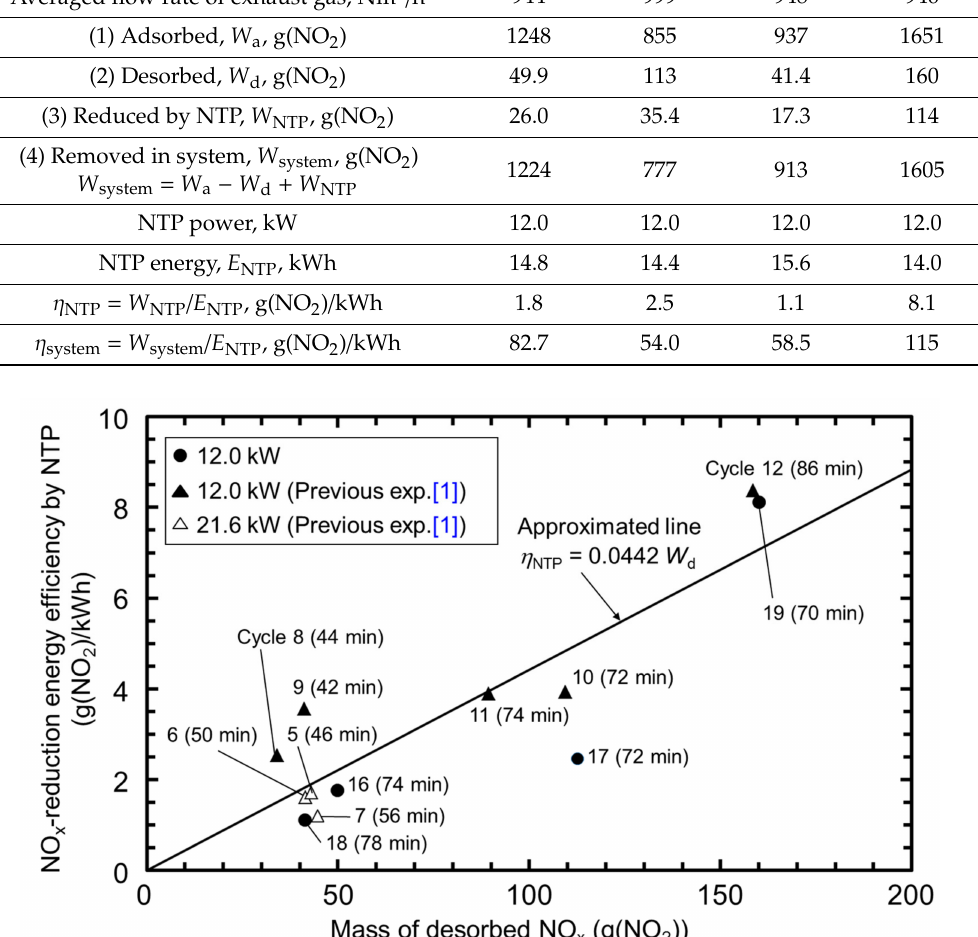
Table 4. Treated NO x amount and removal energy e ffi ciency (g(NO 2 ) / kWh) in cycles 16 − 19. Cycle Averaged flow rate of exhaust gas, Nm 3 / h